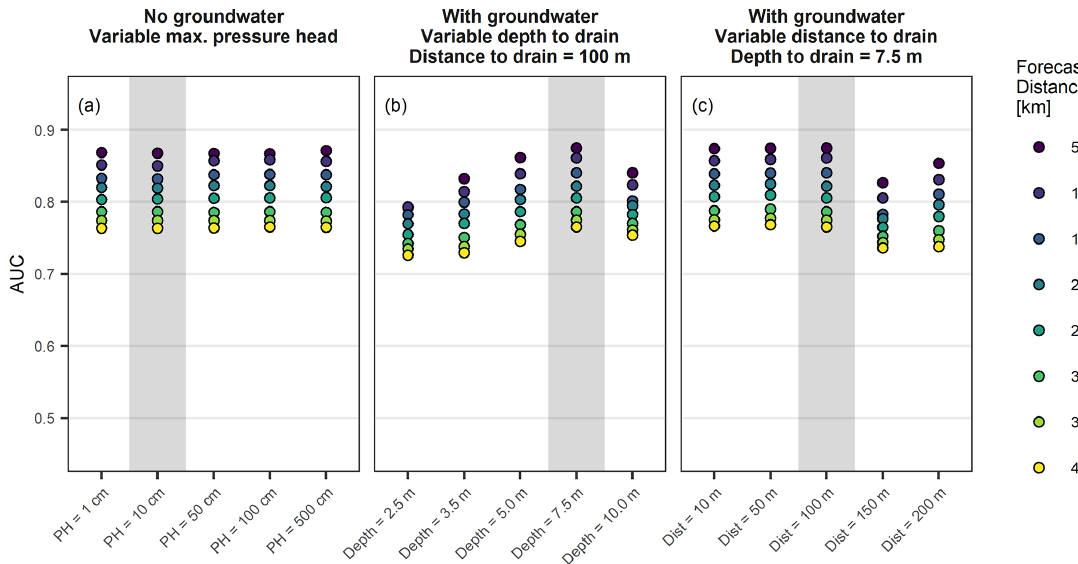
Figure 7. AUC values of landslide forecast model fits with different parameterizations of the lower boundary condition by varying (a) the maximum pressure head of the lowest layer above which exfiltration occurs, (b) depth to the drain and (c) the distance to the drain. Grey shaded model runs correspond to the CoupModel parameterization used in all other analyses.